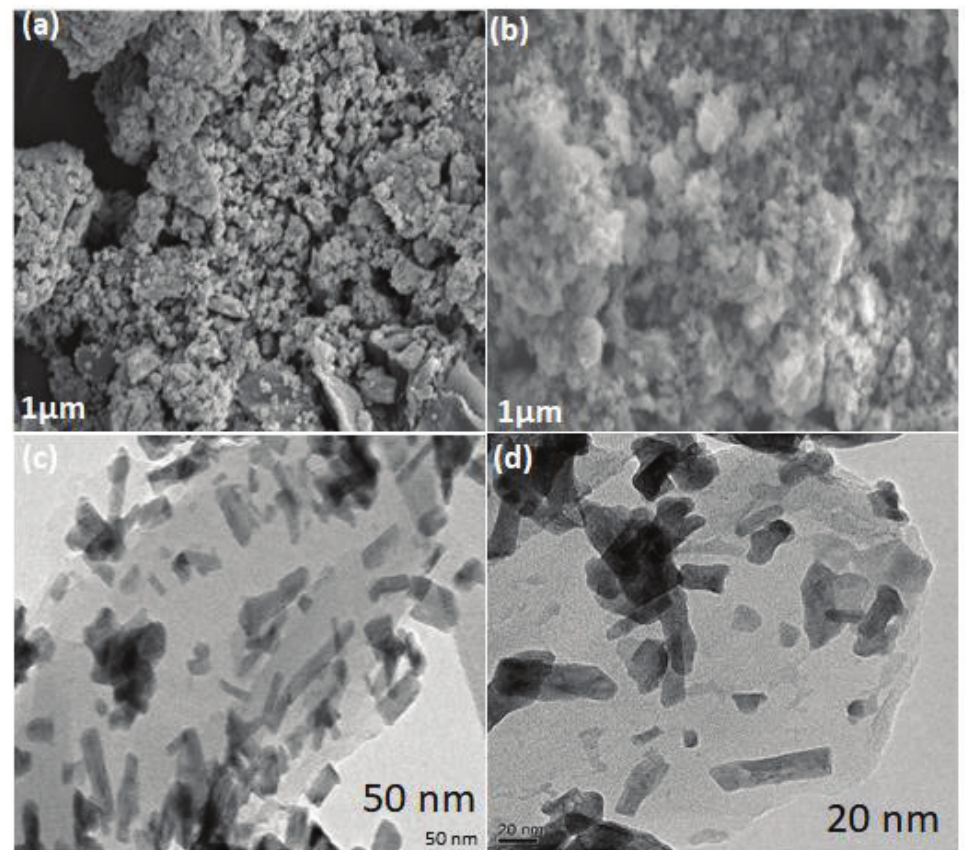
Figure 3. SEM images ( a , b ) and TEM images ( c , d ) of PGO–Gd.